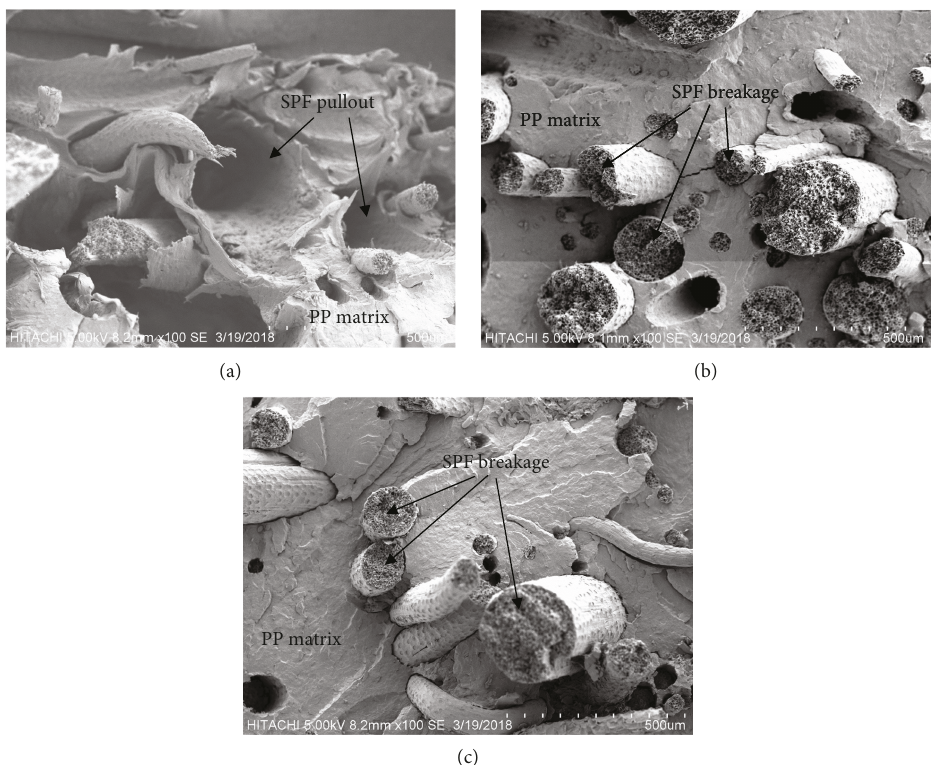
Figure 7: SEM micrographs of the nonhybrid composites of (a) untreated (L02), (b) alkaline-treated (L03), and (c) sodium bicarbonate- treated (L04) SPF-reinforced